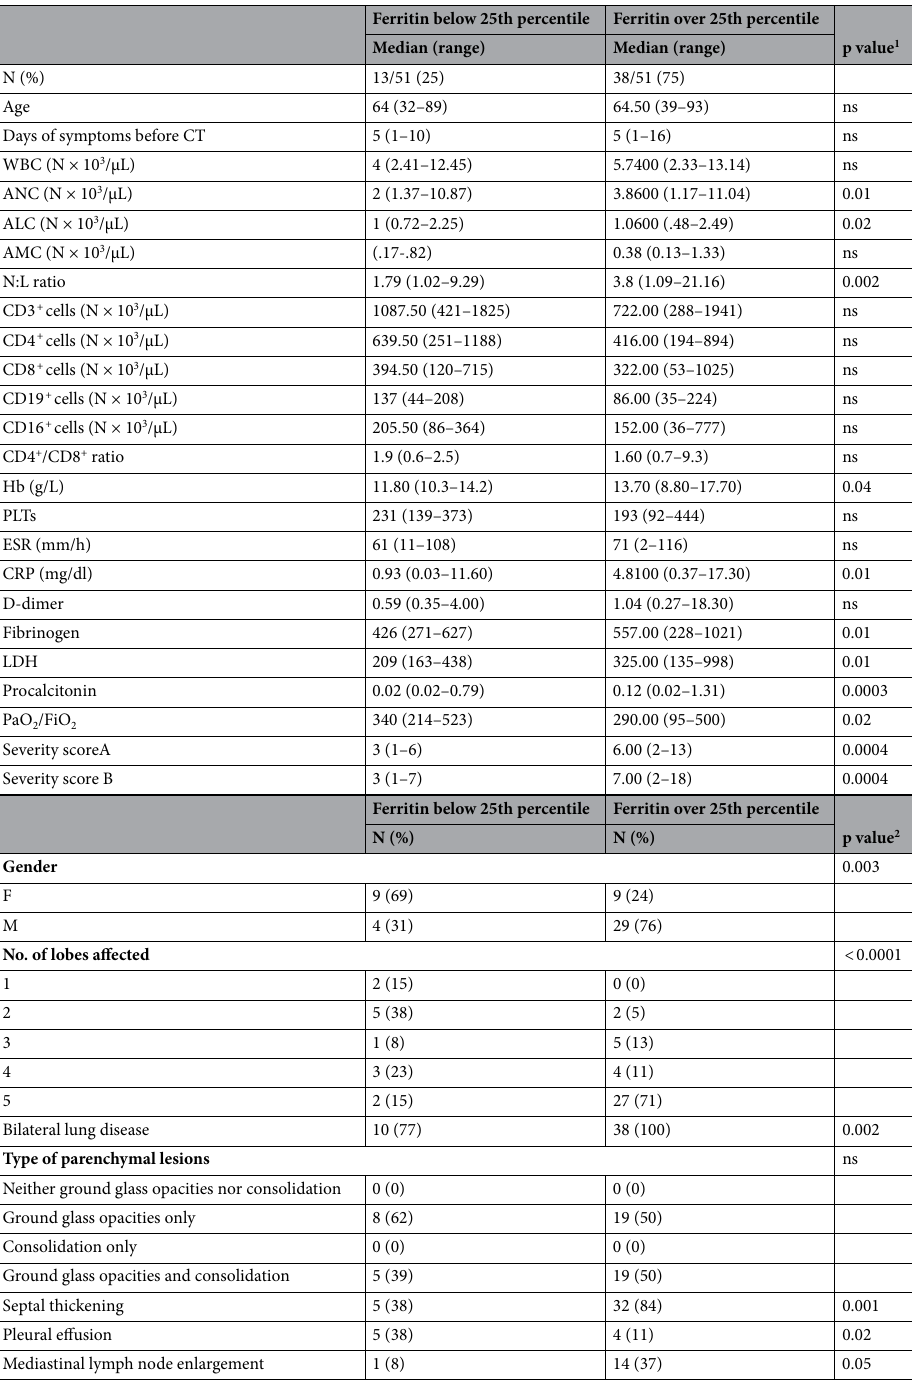
Table 4. Differences across groups dividing patients according to ferritin levels. CT computed tomography, WBC white blood cells, ANC absolute neutrophil count, ALC absolute lymphocyte count, AMC